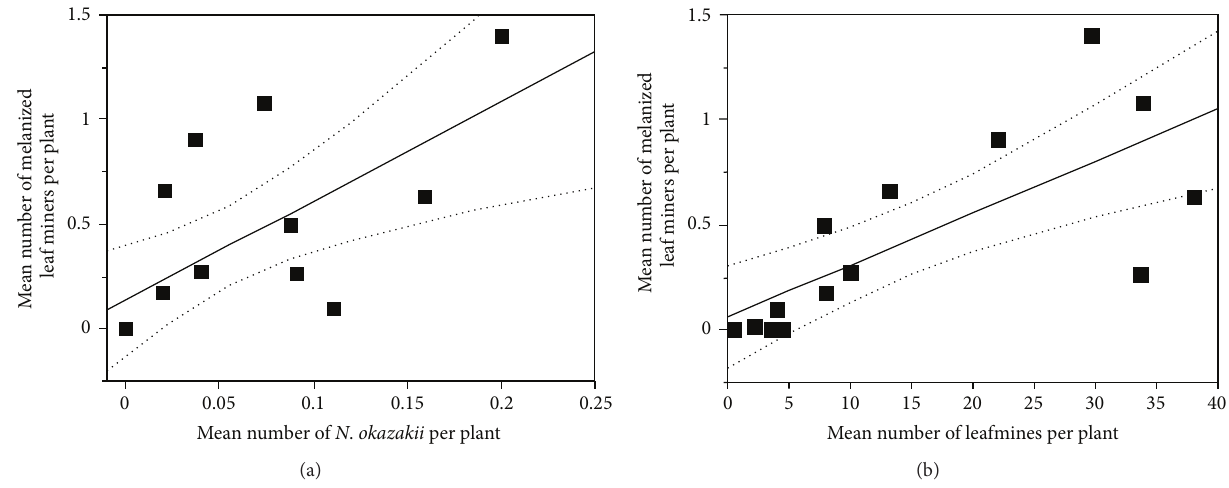
Figure 2: Relationships between mean numbers of melanized leaf miner larvae per plant and levels of leaf miner infestation of green onion fields (a) or mean numbers of Neochrysocharis okazakii found per plant (b). Dot lines indicate 95% confidence intervals.